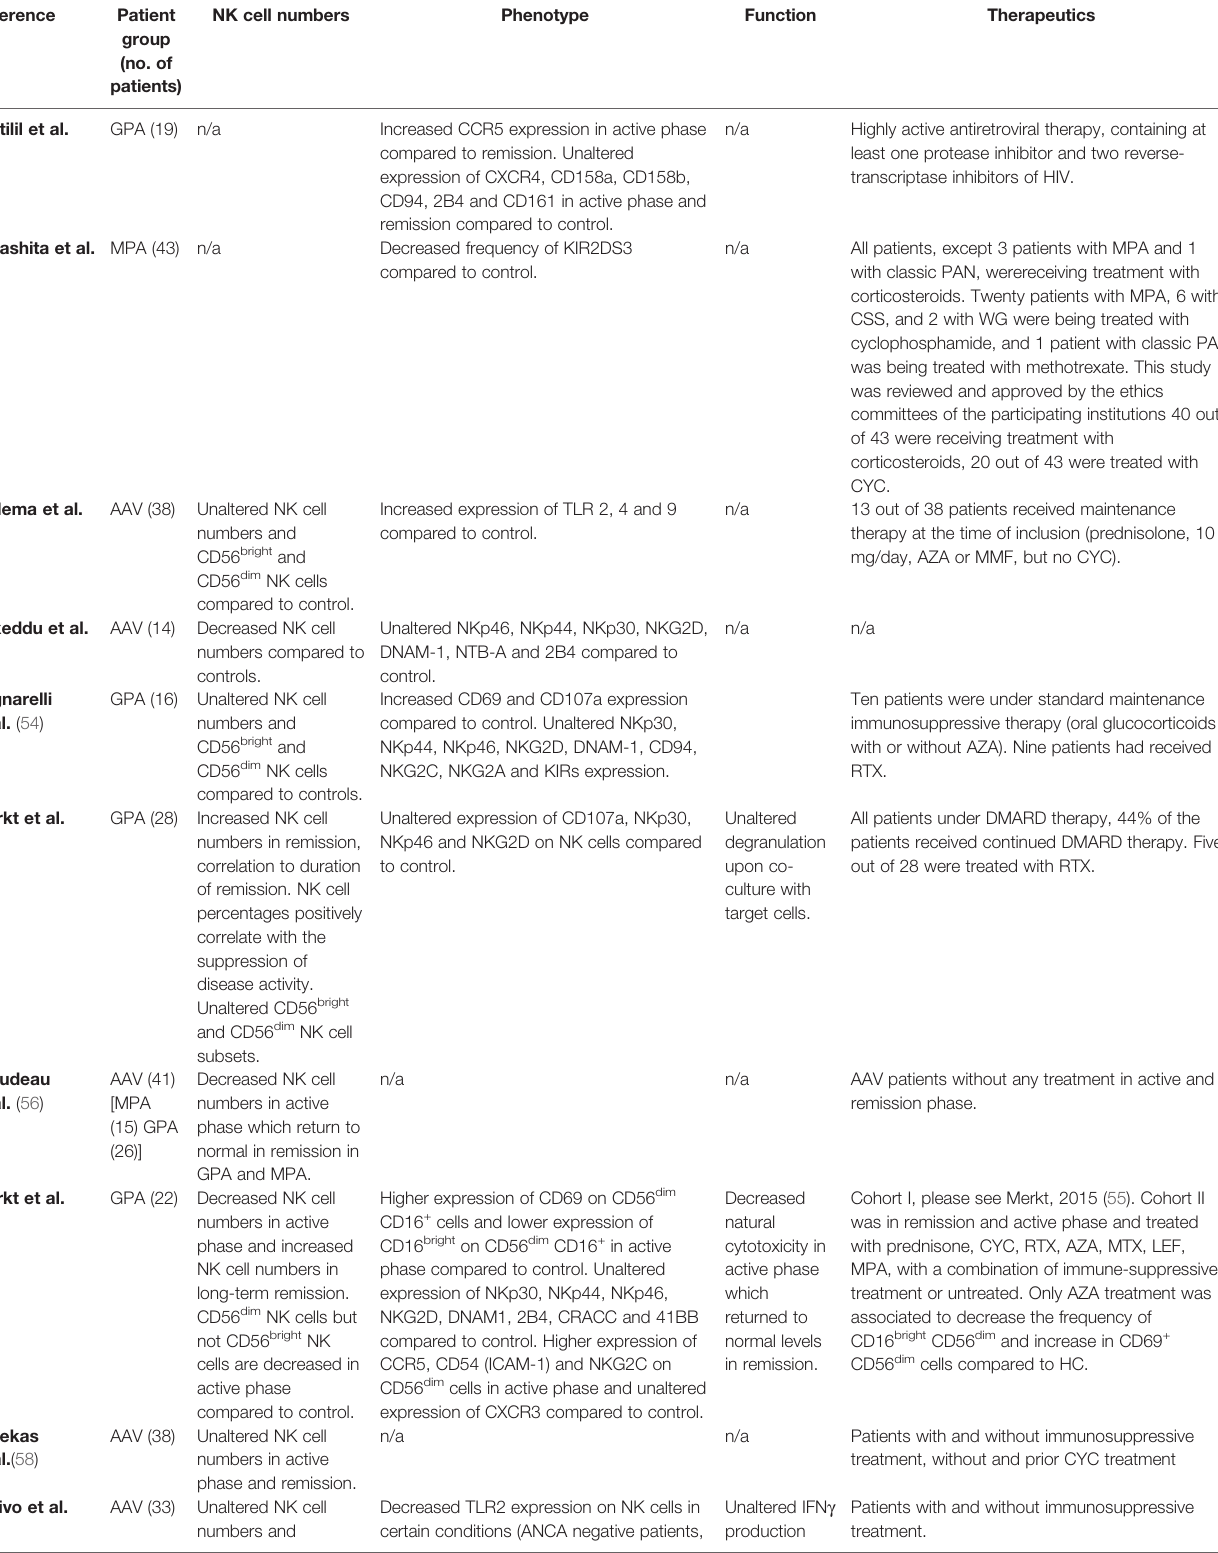
TABLE 1 | NK cells in circulation of AAV